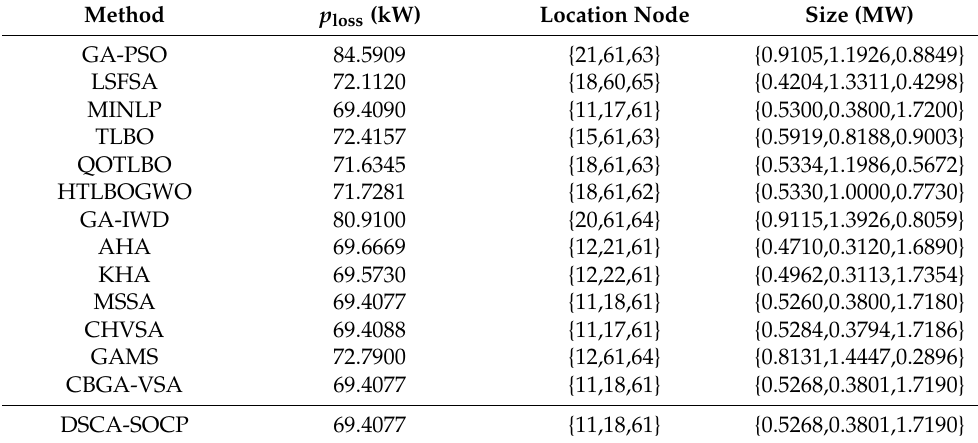
Table 3. Optimal location and sizing of DGs in the 69-node test feeder for the proposed and compara- tive